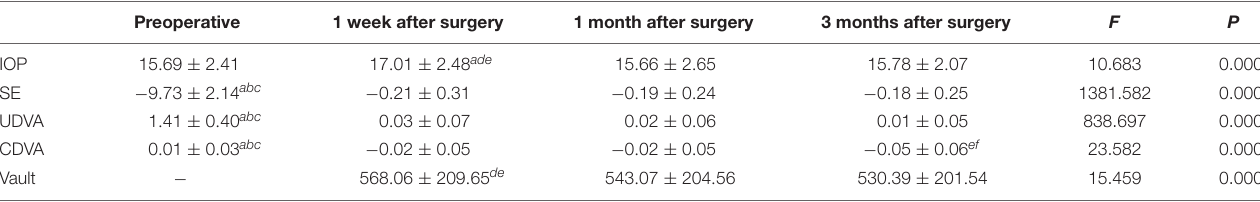
FIGURE 1 | OCTA image of the macular area and optic disk. (A) The macular avascular area. (B) The fovea (the range within the inner ring) and the paracentral fovea (the range between the inner and outer rings). The diameter of the inner ring is 1.0 mm, and the diameter of the outer ring is 3.0 mm. The macular fovea is divided into upper, lower, nose, and temporal quadrants. (C) Images of para-optic disk (the range between the inner ring and the outer ring). It is divided into four quadrants: upper, lower, nose, and temporal. TABLE 1 | Comparison of general conditions of patients before and after